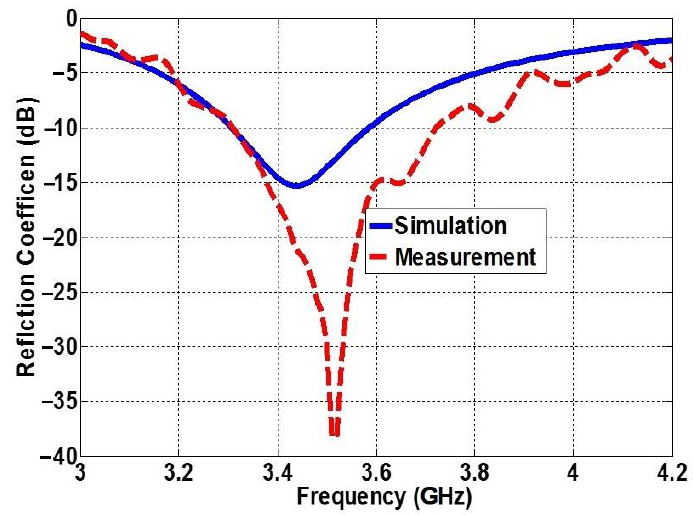
Figure 2. Simulation and measurement results of reflected coefficient of the CPW antenna.